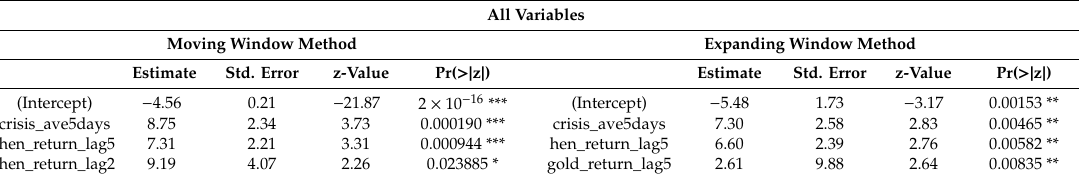
Table A2. Estimated LogR model result: All